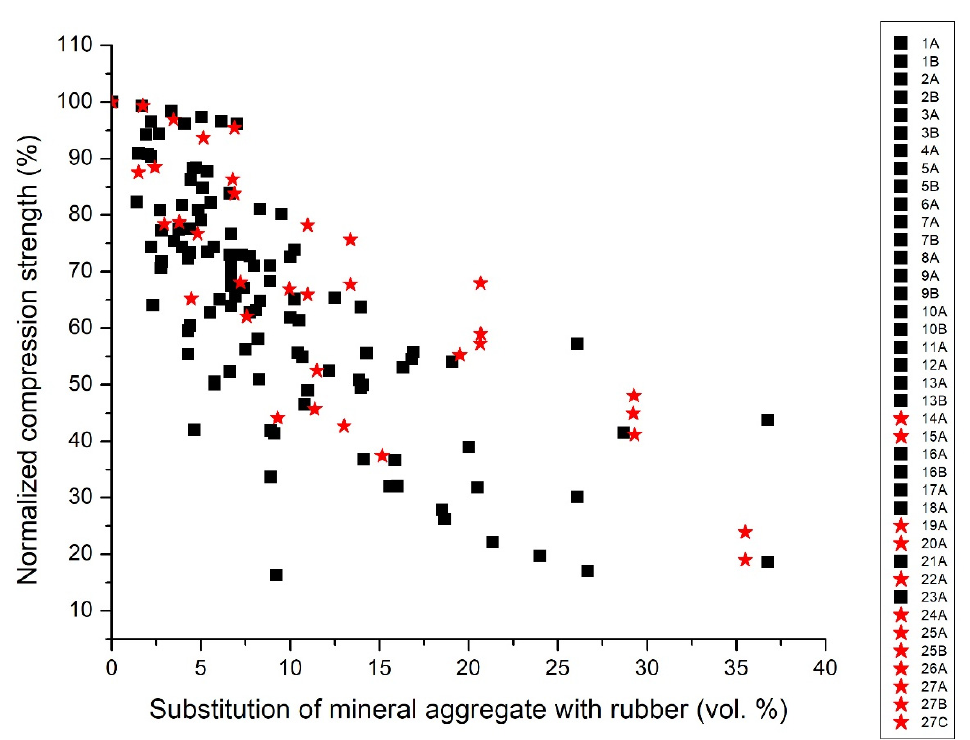
Figure 5. Reference diagram: normalized compression strength (expressed in %) vs. the volumetric percentage of substitution of the mineral aggregate with rubber (expressed in vol.%) recalculated using the fixed values of reference specific weight. Comparison using high-performance concrete (red stars) vs normal cement (black squares) .